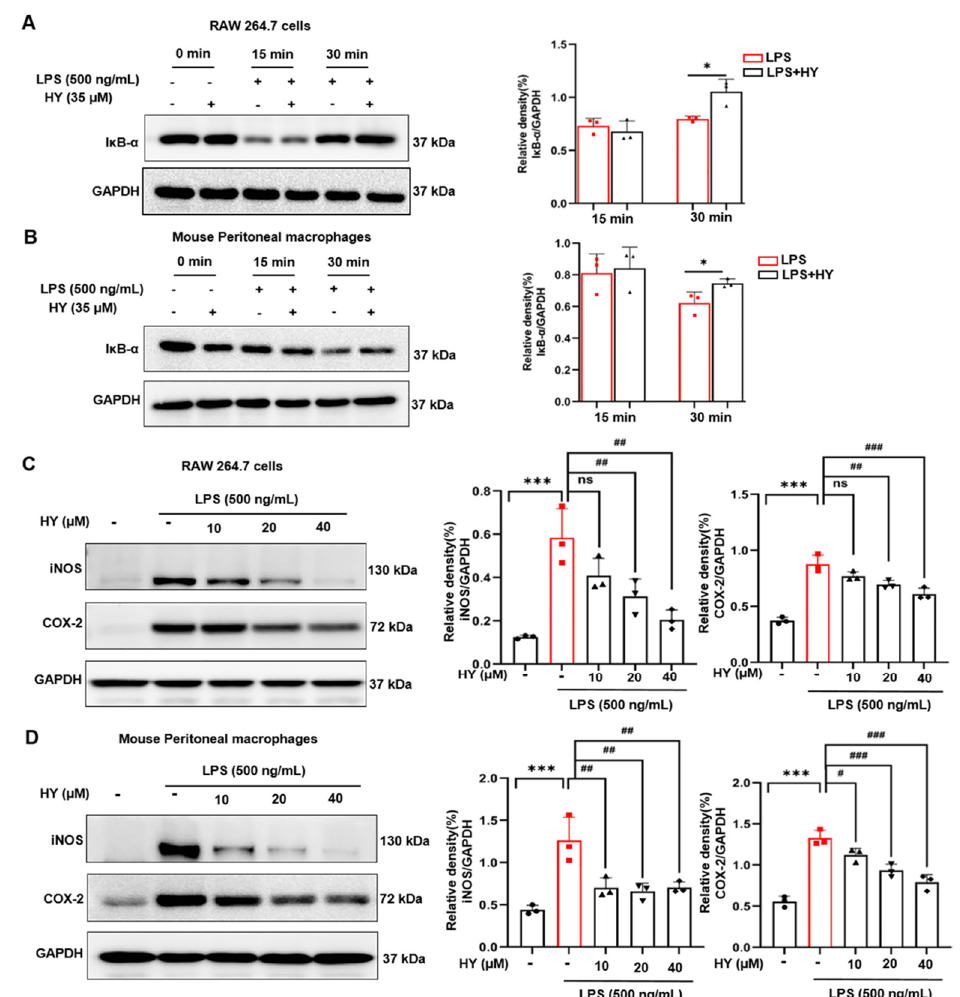
Figure 6. ( A ) Western blot analysis for the inhibitory effect of hyssopuside (HY) on the degradation and quantitative of inhibitor of NF- κ B (I κ B) in RAW 267.4 cells. ( B ) Western blot analysis for the inhibitory effect of HY on the degradation and quantitative of I κ B in mouse peritoneal macrophages. Data are representative of three replicates and shown as mean ± SD. * p < 0.05 versus the lipopolysaccharide (LPS) group. ( C ) Western blot analysis of the inhibitory effects of HY on the protein expression level of inducible nitric oxide synthase (iNOS) and cyclooxygenase-2 (COX-2), and quantitative analysis of iNOS and COX-2 expression level in RAW 267.4 cells. ( D ) Western blot analysis of the inhibitory effects of HY on the protein expression level of iNOS and COX-2 and quantitative analysis of iNOS and COX-2 expression levels in mouse peritoneal macrophages. Glyceraldehyde 3-phosphate dehydrogenase (GAPDH) was detected and used as an internal control. Data are representative of three replicates and shown as mean ± SD; *** p < 0.05 versus the control group; # p < 0.05, ## p < 0.01, ### p < 0.001 versus the LPS-treated